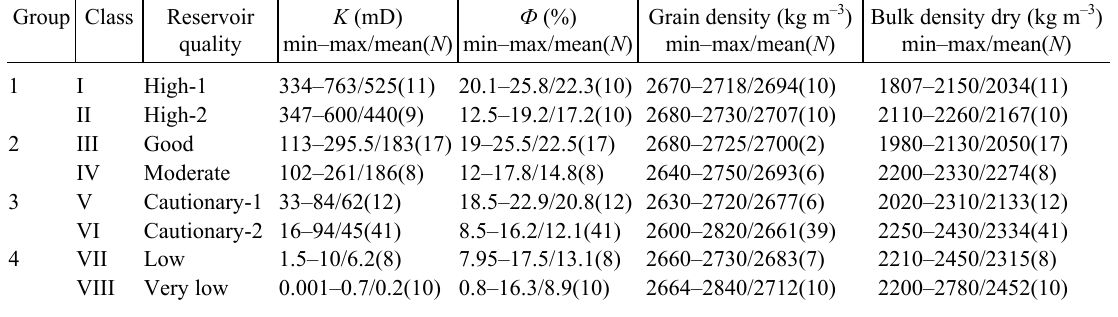
Table 2. Average properties of the sandstones of the Deimena Formation before the alteration experiment Group Class